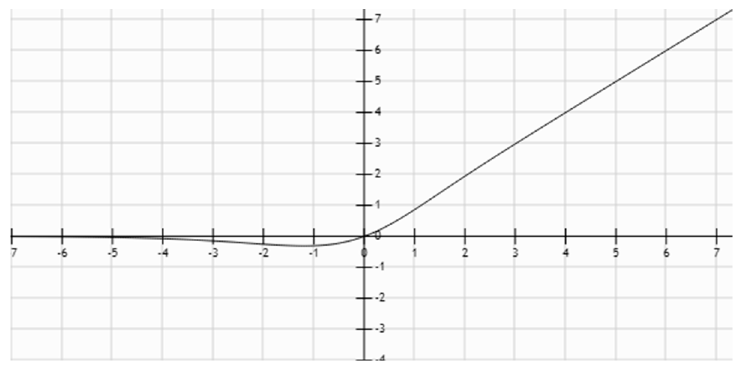
Figure 4. This Mish activation function